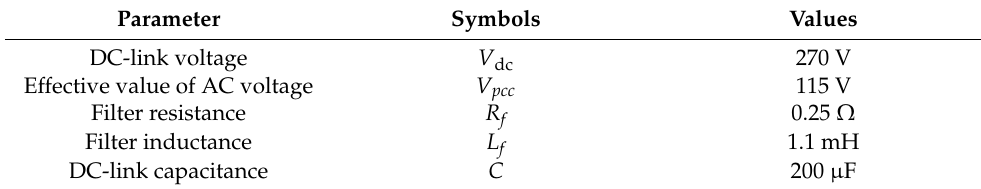
Table 1. Parameters of the system.